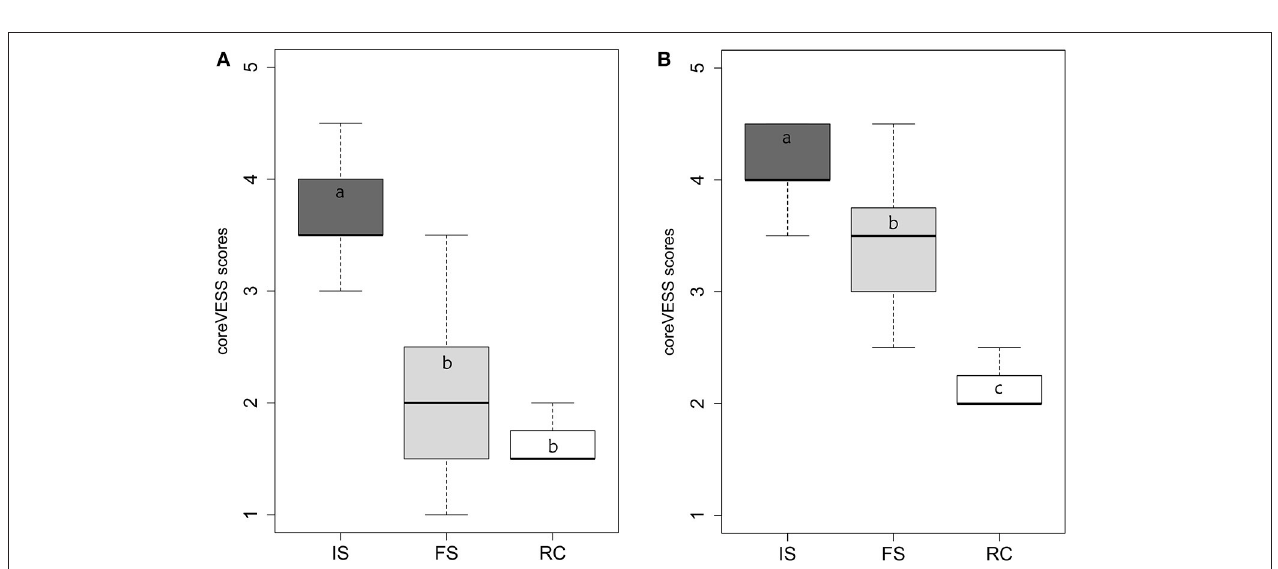
FIGURE 2 | Boxplots of the structure quality scores at initial (IS) and final (FS) states, and of the reference condition (RC), for (A) 5–10cm depth and (B) 20–25cm depth. Letters a, b, c indicate significant differences at the p < 0.05